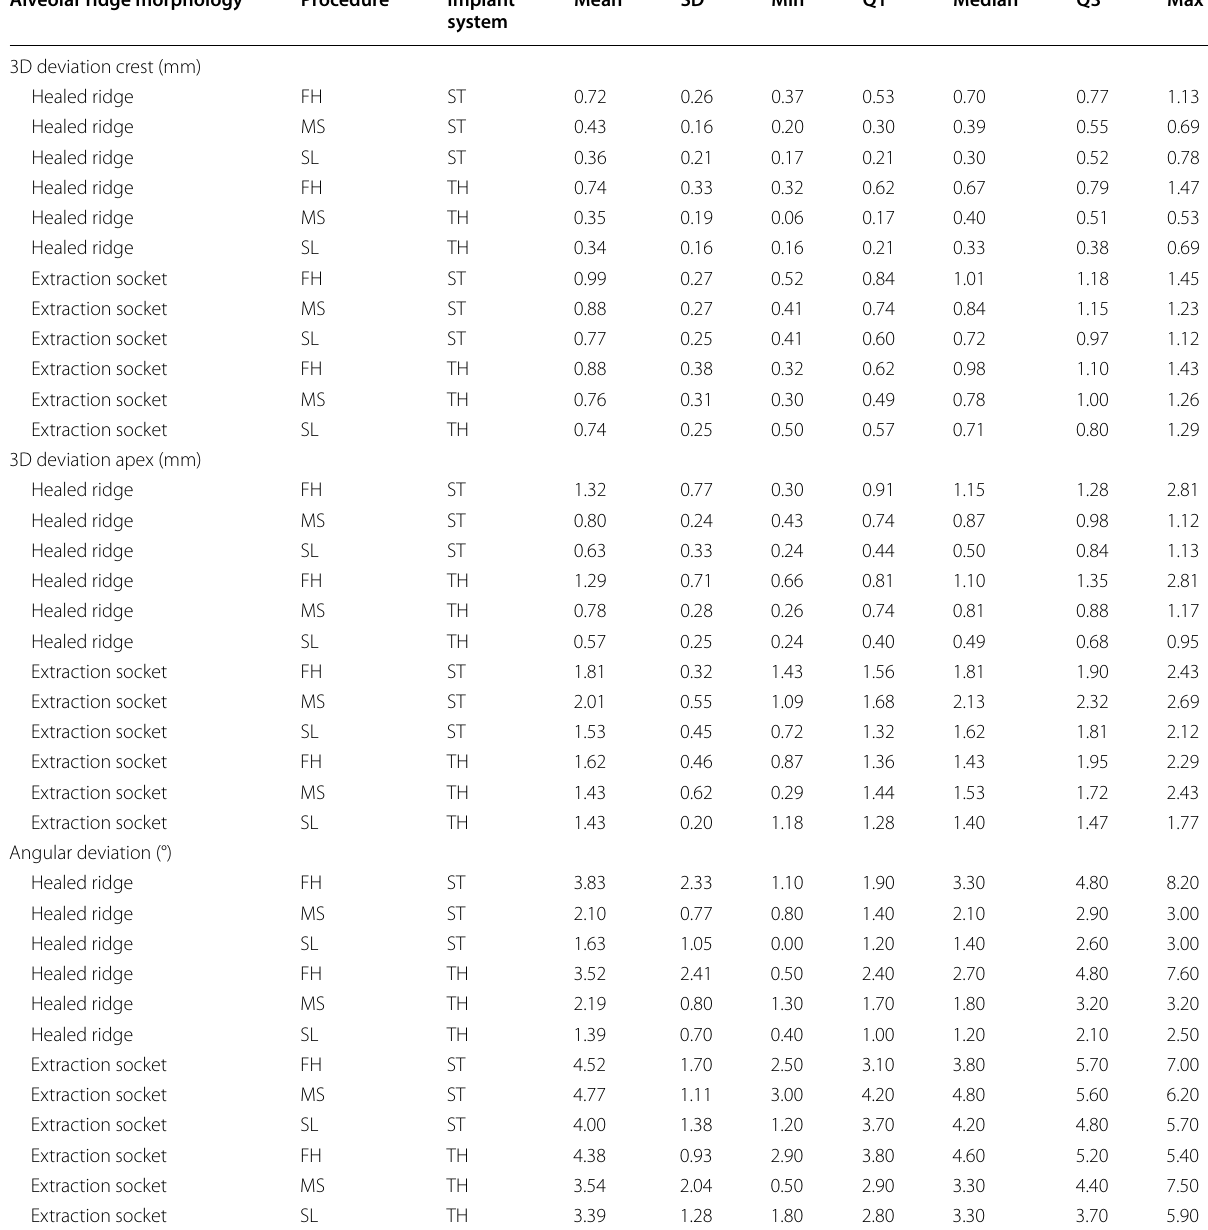
Table 1 Descriptive statistics of the crest, apex, and angular 3D implant deviation for each of the subgroups: alveolar ridge morphology, procedure, and implant